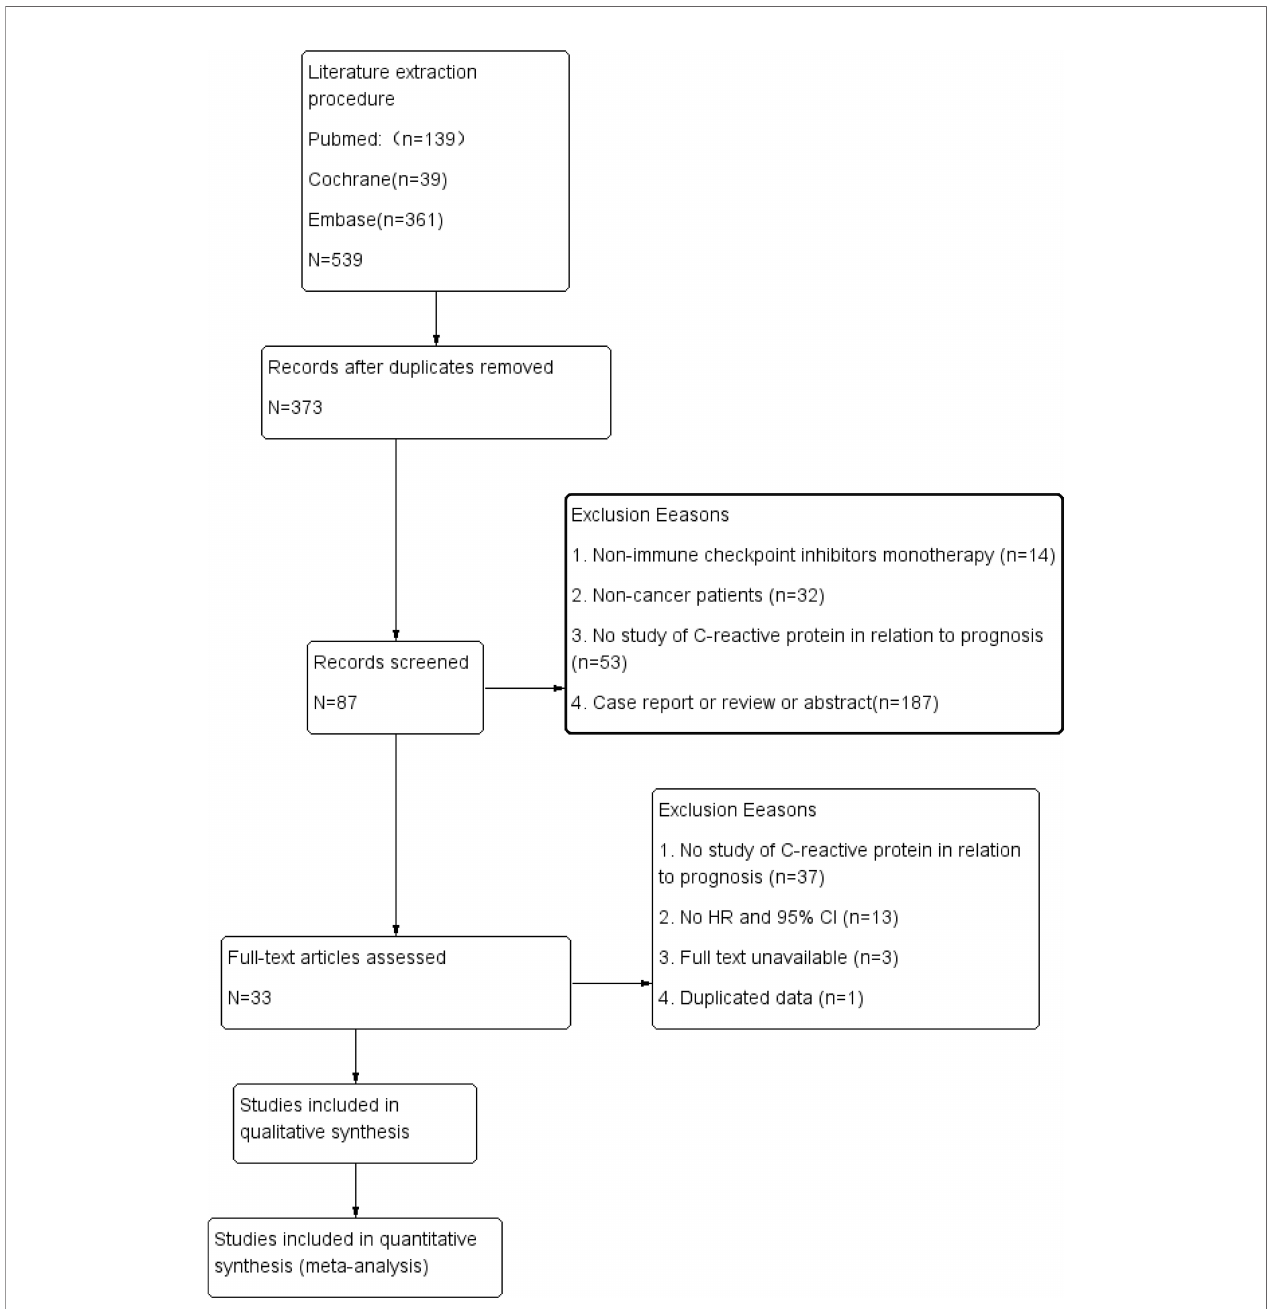
FIGURE 1 | Flowchart of this meta –